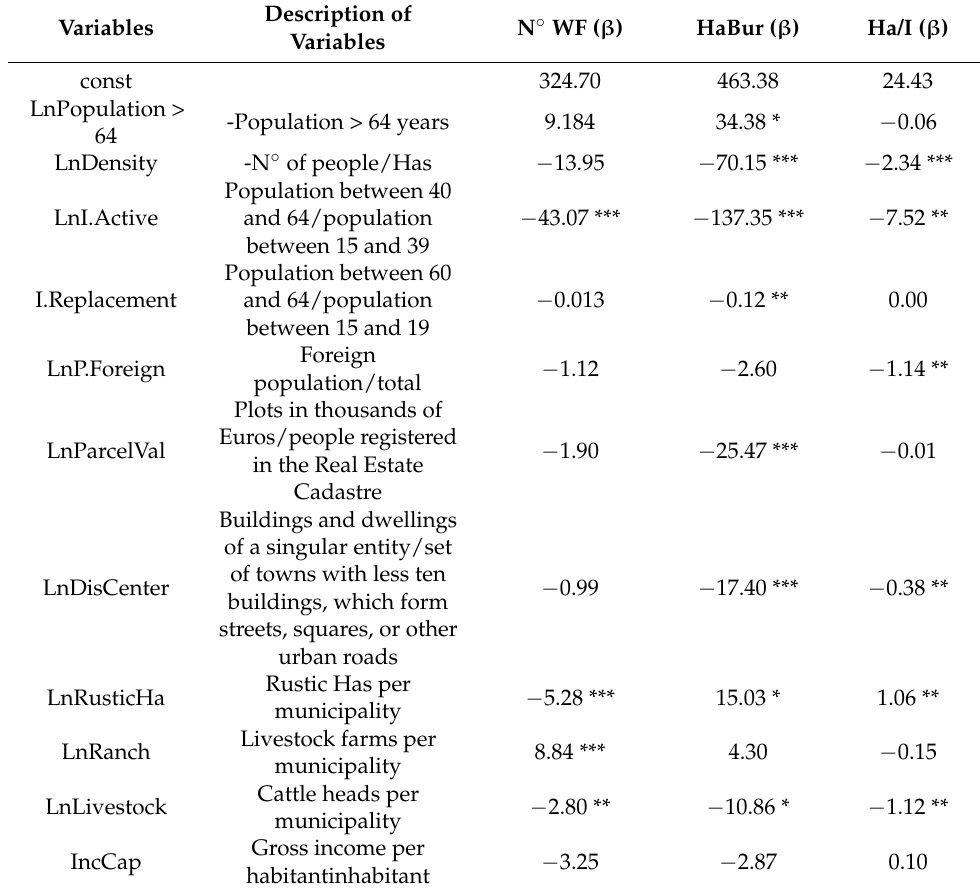
Table 2. Models. N ◦ WF: Number of wildfires (using fixed effects). Ha Bur: Hectares burned and Ha/I: Hectares burned/Ignitions (using random